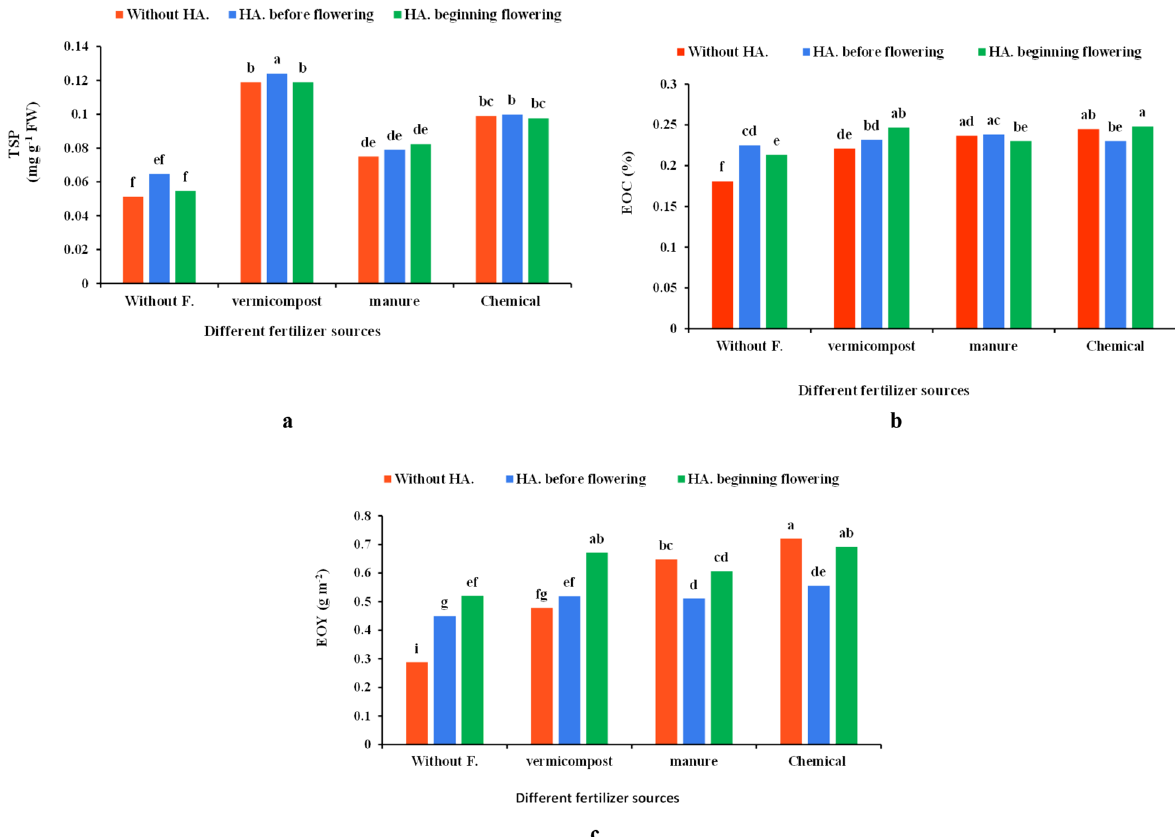
Figure 4. Effect of different fertilizer sources × humic acid (HA) treatments on TSP ( a ), essential oil content (EOC) ( b ), essential oil yield (EOY) ( c ), and total soluble protein content (TSP) ( d ) of coriander plants. Different letters indicate significant differences according to LSD test P < 0.05 (average of two years).